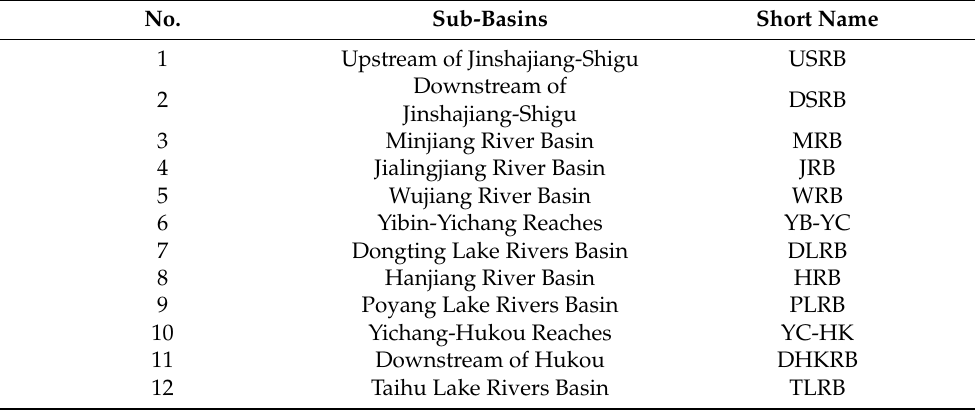
Table 1. The codes and their related sub-basins in the YRB .